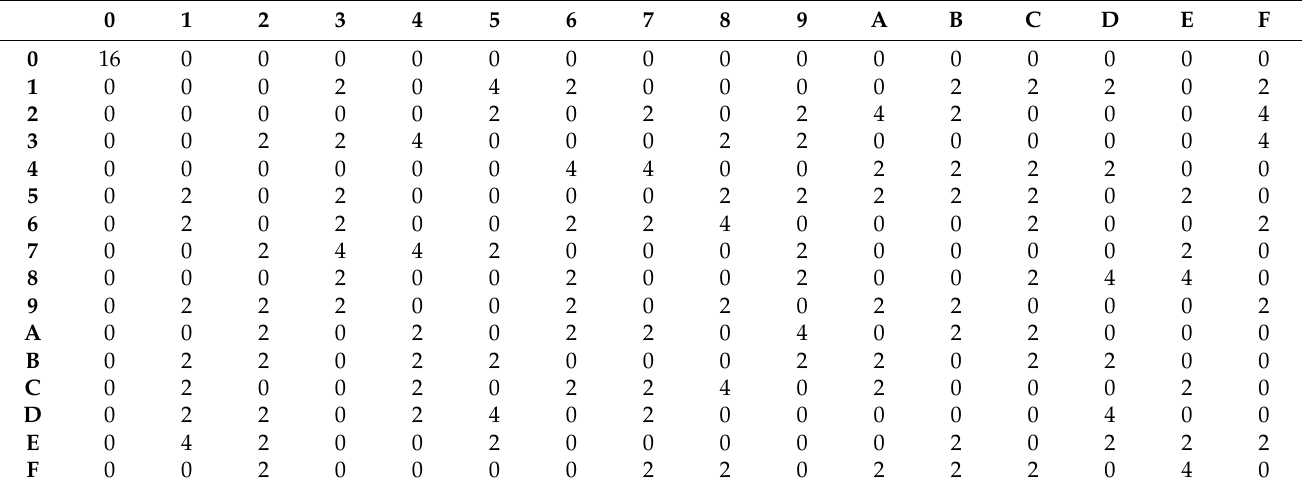
Table 2. S 0 box